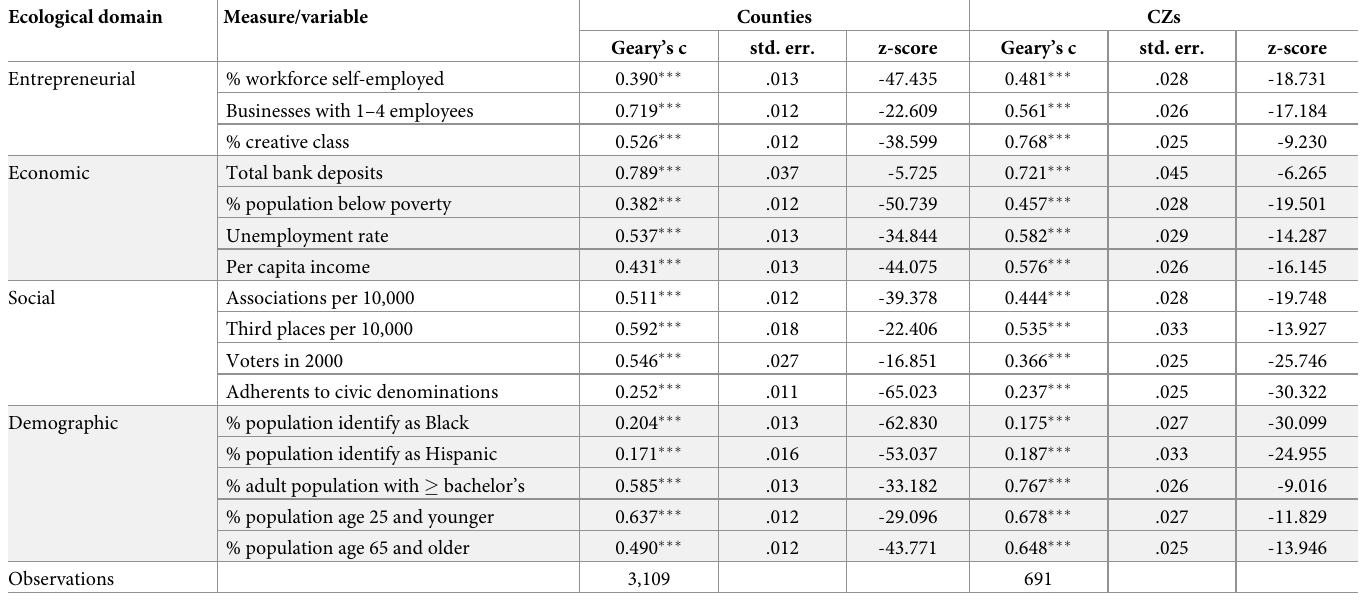
Table 4. Global Geary’s c for entrepreneurial, economic, social, and demographic domains (Counties vs. CZs). Ecological